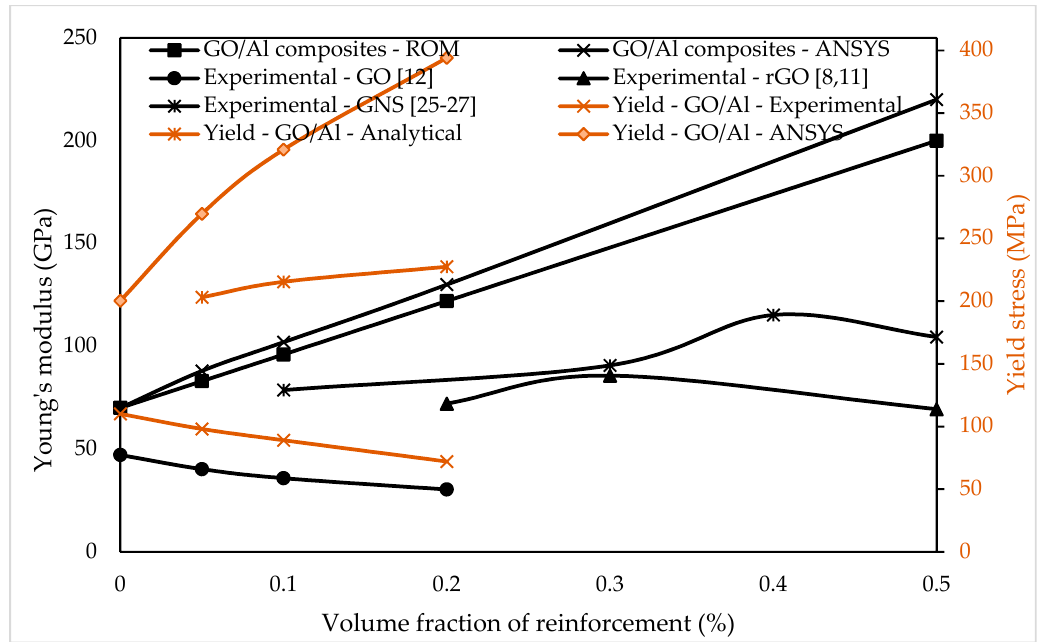
Figure 5. Comparison of Young’s modulus of GO/Al composite developed in ANSYS with ROM and experimental studies at different volume fractions and comparison of Yield stress of GO/Al composite estimated in analytical modeling with experimental studies.